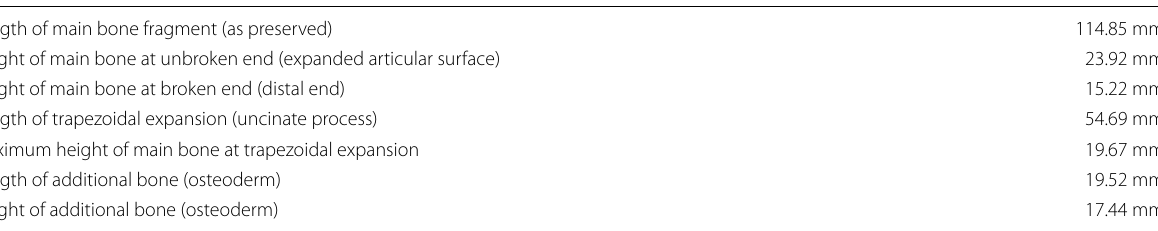
Table 1 Measurements of PIMUZ A/III 5166, a thoracic rib and associated osteoderm Length of main bone fragment (as preserved) 114.85 mm Height of main bone at unbroken end (expanded articular surface) 23.92 mm Height of main bone at broken end (distal end) 15.22 mm Length of trapezoidal expansion (uncinate process) 54.69 mm Maximum height of main bone at trapezoidal expansion 19.67 mm Length of additional bone (osteoderm) 19.52 mm Height of additional bone (osteoderm) 17.44